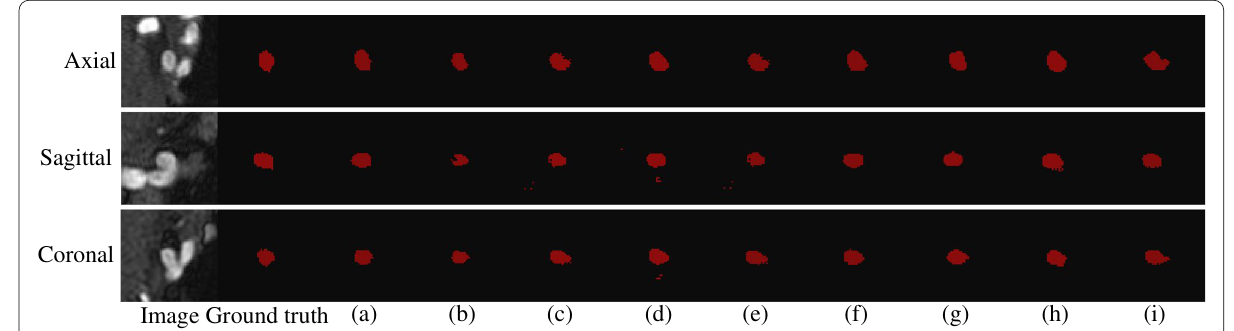
Fig. 6 Prediction maps for the models with different components, on the MICCAI 2020 ADAM testing set. The first column is the MRA image of an aneurysm, while the second column shows the manually obtained marking mask. a The proposed model; b U-Net; c U-Net with the dense block; d U-Net CAM; e U-Net SAM; f U-Net CBAM; g U-Net dense block CBAM; h BN only; i With ReLU + + + + +